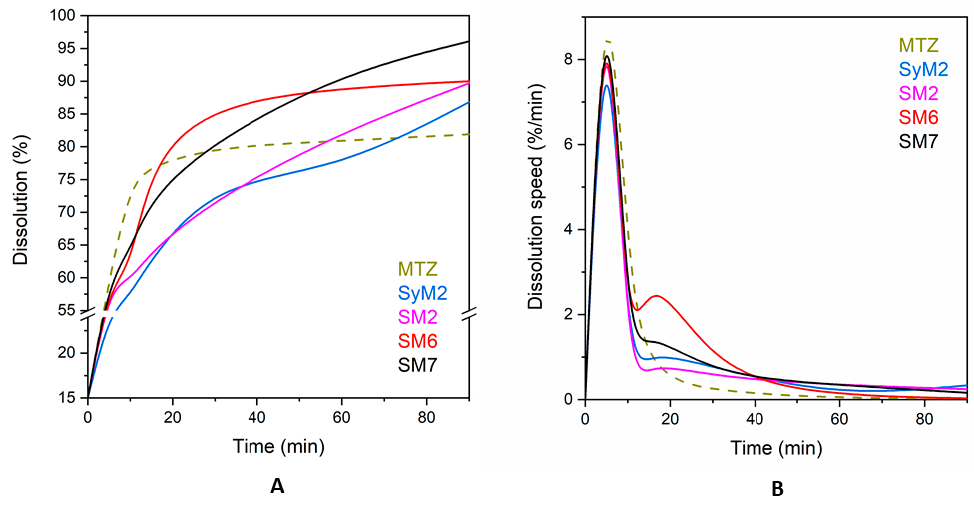
Figure 8. Dissolution of MTZ from its pure and immobilized form ( A ) and dissolution speed of MTZ from its pure and immobilized form ( B ).